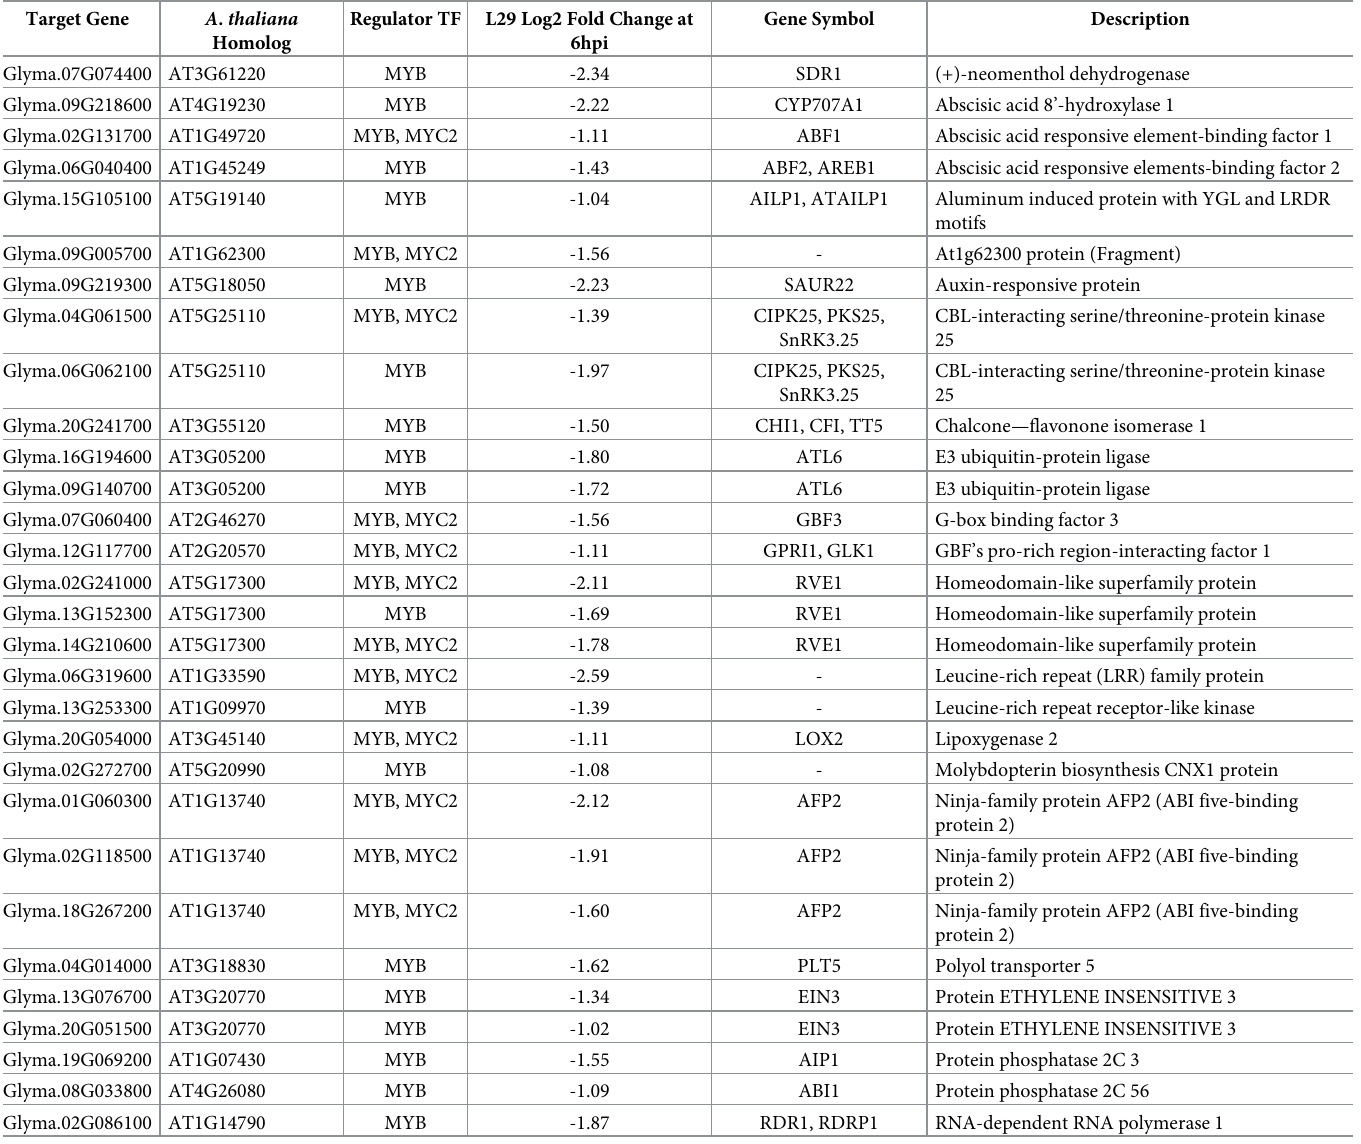
Table 2. TF target genes in module-2 related to ABA and auxin processes and defense responses. Target